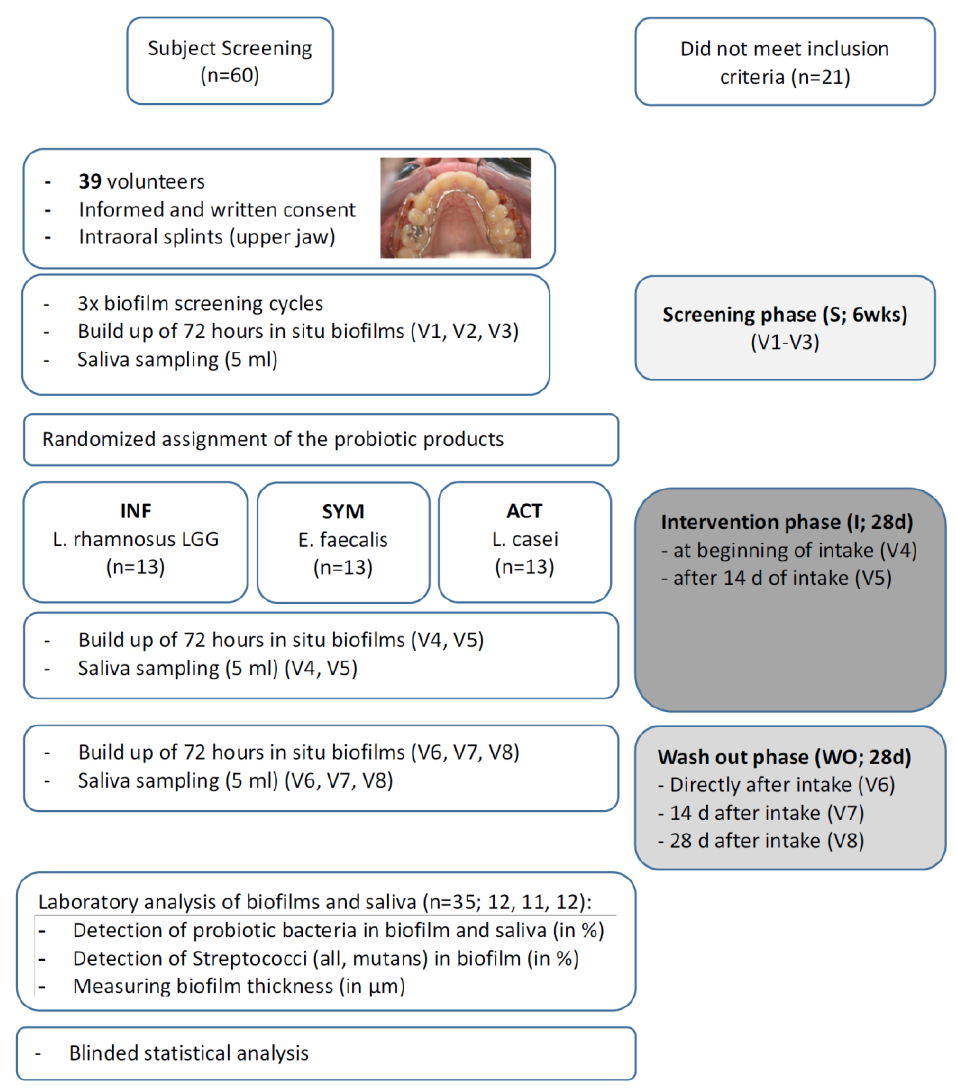
Figure 1. Flow chart of the study.